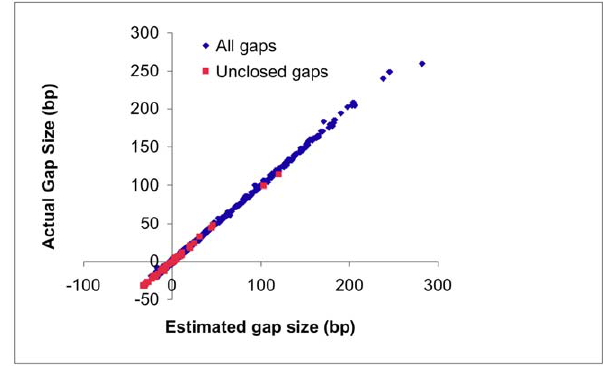
Figure 4. Estimated gap sizes vs. actual contig separation in the Pichia genome. 75% of the initial inter-contig gaps are resolved during gap closing. 97% of gaps are found to be within 4 bp of their estimated size, and 58% within 1